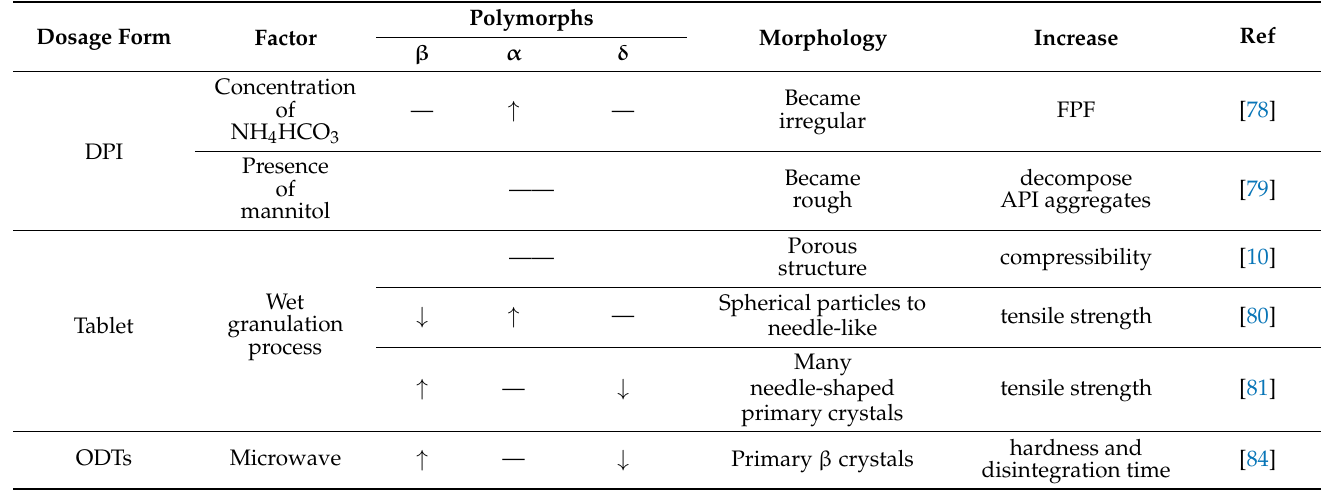
Table 3. Change of content, morphology, and properties of mannitol polymorphs under different factors in DPI and tablet